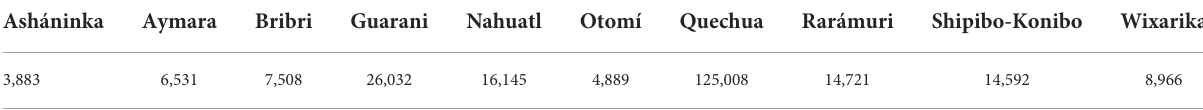
TABLE 4 Overview of the sizes of the training sets provided for the AmericasNLP 2021 Shared Task on Open Machine Translation (Mager et al.,